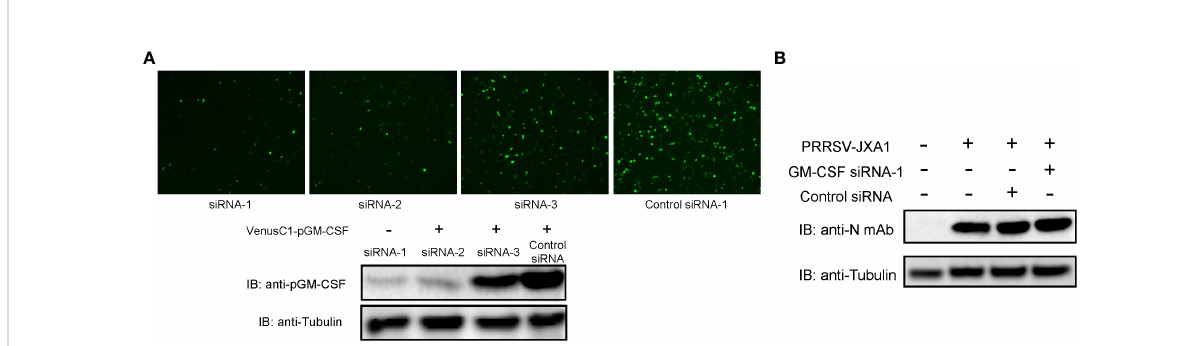
FIGURE 4 Knock-down of pGM-CSF in BM-DCs did not promote PRRSV replication in vitro . (A) HEK-293T cells were transfected with pVenusC1-pGM- CSF plasmids for 5 hours, then followed by transfection of 1 m g pGM-CSF siRNAs or control siRNA for additional 24 hours. Next, the cells were observed directly under microscope of harvested for western blot using pGM-CSF speci fi c mAb-2A4H11. Tubulin was probed from the same samples and included as protein loading control. (B) BM-DCs were either transfected with 1 m g pGM-CSF siRNA-1 or control siRNA for 24 hours or left as un-transfected cells before inoculated with PRRSV-JXA1 strains (0.1 MOI) for additional 24 hours. Next, cells were harvested for SDS-PAGE followed by western blotting assay using anti-PRRSV-N speci fi c mAb-6D10. Tubulin was probed from the same membrane as a loading control.